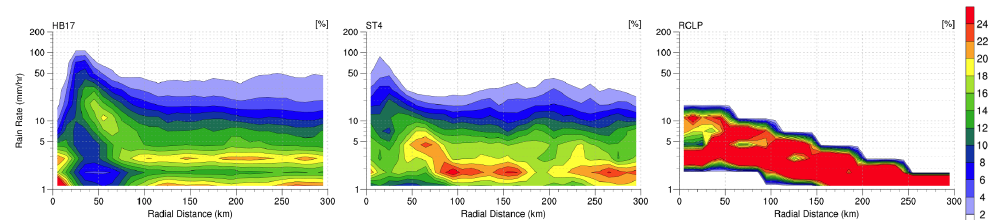
Figure 10. Contoured frequency by radial distance (CFRD). The distance interval is 10 km starting from 0 to 300 km, and the rain rate interval is 2 dBR. From the left to the right panel, the results are from HB17, Stage IV, and R-CLIPER